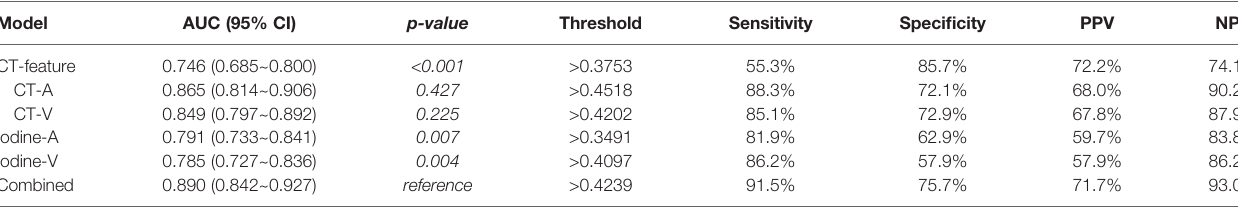
TABLE 2 | Performance comparison of different models in the development set.